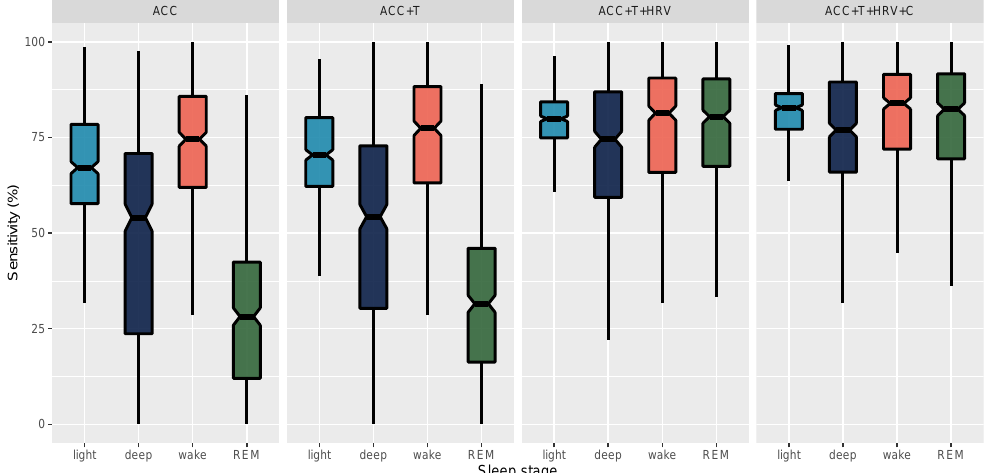
Figure 11. Epoch by epoch sensitivity for 4-stage classification and the four models compared in this paper. Whiskers are computed as 1.5 times the interquartile